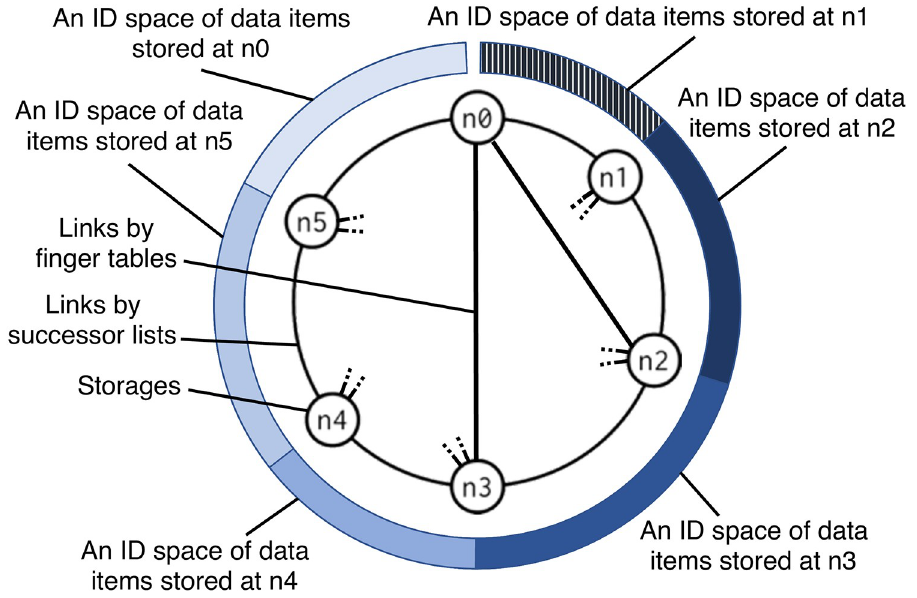
Fig 1. A topology of a overlay network and ID space in Chord or